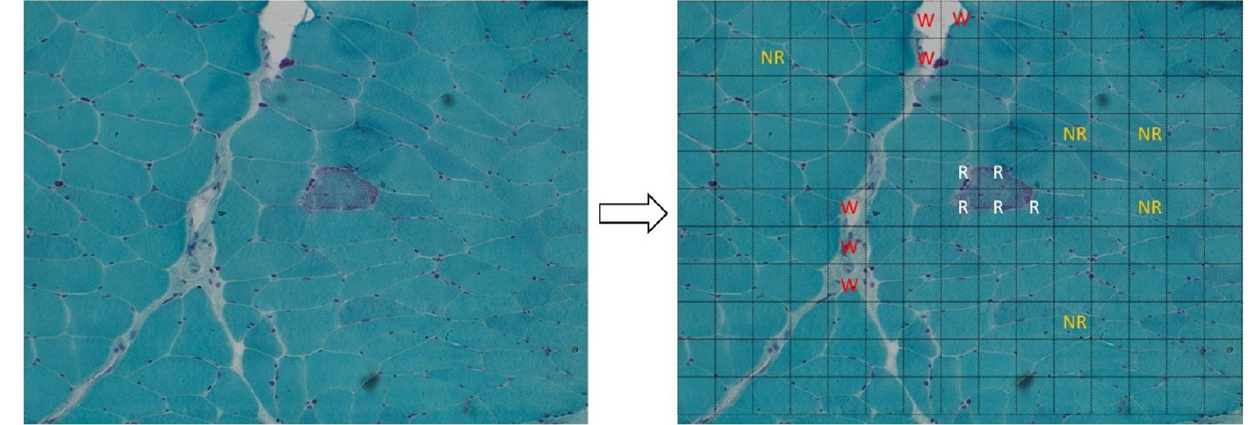
Figure 1. Left panel: ragged red fiber (RRF), hallmark of mitochondrial disorders, in Gomori’s trichrome stain (magnification: 20×; image acquired from the muscle of patient 8). Right panel: it shows the method used to create the dataset for our analysis: each acquired image was subdivided in 165 sub-images (15 × 11). All the sub-images that contain a portion of an RRF were added to the dataset and labeled as “ragged” (R label in the figure, written in white). After that, we arbitrarily collected a similar number of sub-images that do not contain RRFs, labeling them as “not ragged” (NR label, written in orange) and some “waste” sub-images (W label, written in red). The rest of the sub-images were discarded to avoid the unbalancing of the dataset.